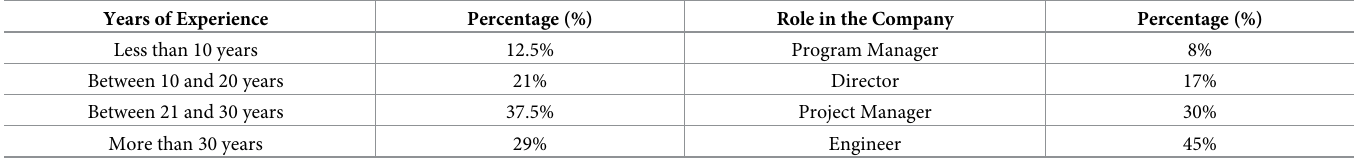
Table 3. Respondents’ demographic information.